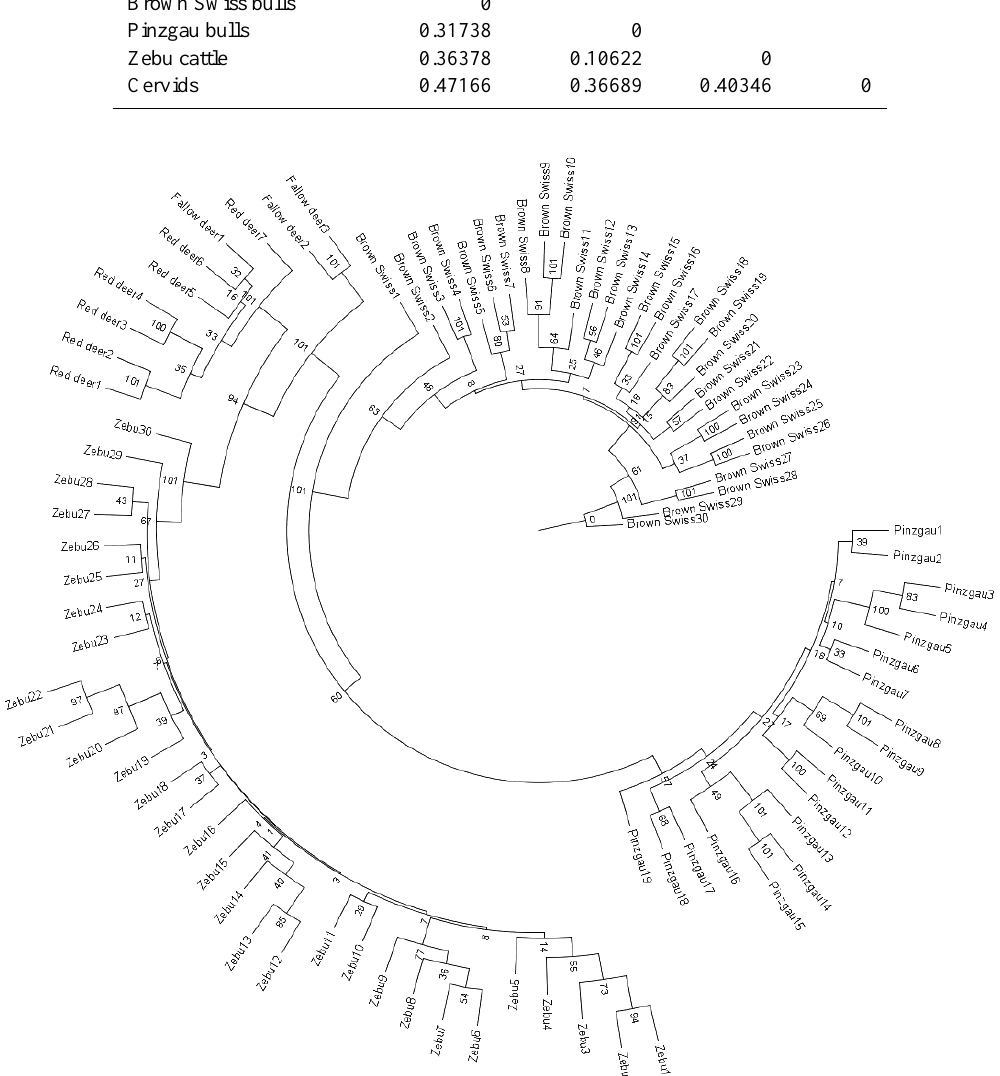
Figure 3. Neighbour-joining tree clustering genetic distances and bootstraps estimates among zebu, two taurine breeds and cervids.